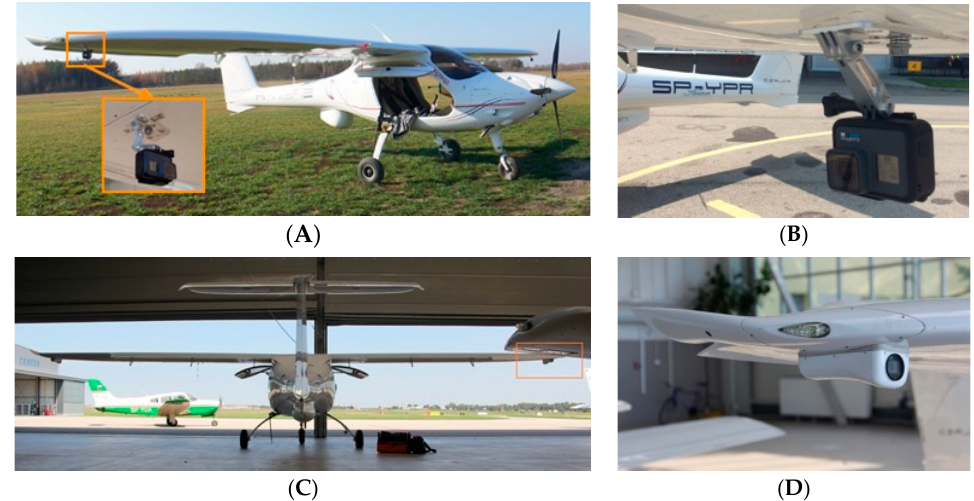
Figure 7. MP-02 Czajka plane with a GoPro 7 camera installed for preliminary experiments ( A , B ) and its installation for the planning of more advanced experiments in the future ( C , D ).